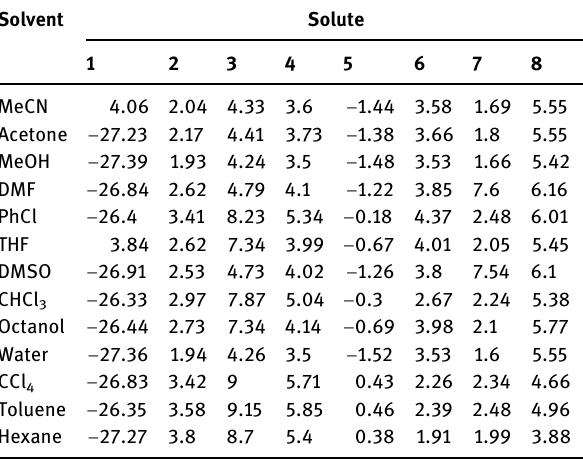
Table 13: Calculated di ff erences between values of λ max for azoles 1 – 8 at the WB97XD/6 - 311 ++ G ( 2d,3p ) //WB97XD/6 - 31G ( d,p ) level of theory in the PCM solvation model and the gaseous phase ( Δ